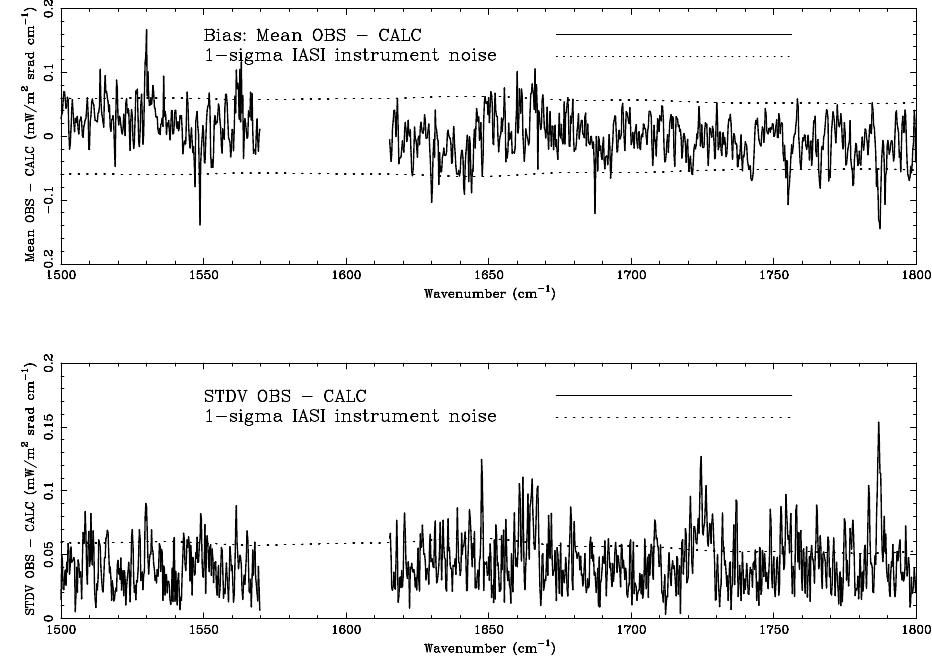
Fig. 14. Bias and standard deviation of IASI observed minus calculated radiances. The calculated radiances have been obtained using OSS and the “in situ” bias correction.